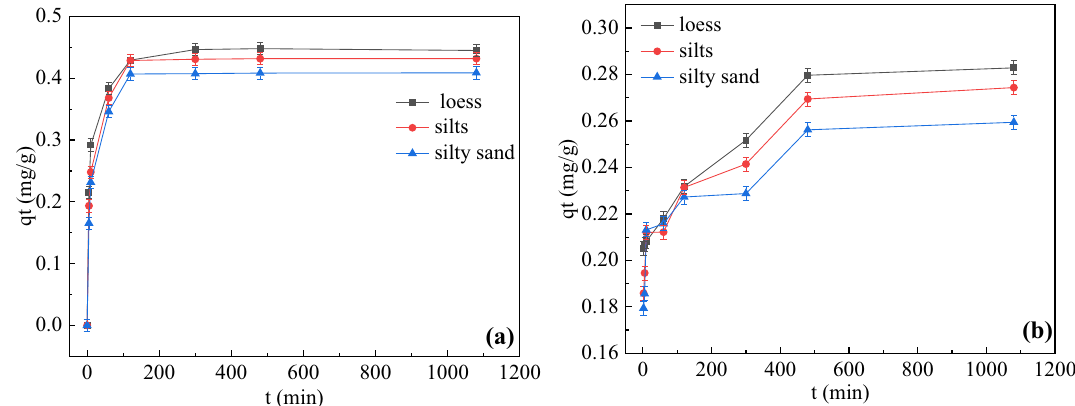
Figure 2. ( a )Adsorption equilibration curves of phenanthrene sorption in soils. ( b ) Desorption equilibration curves of phenanthrene sorption in soils.